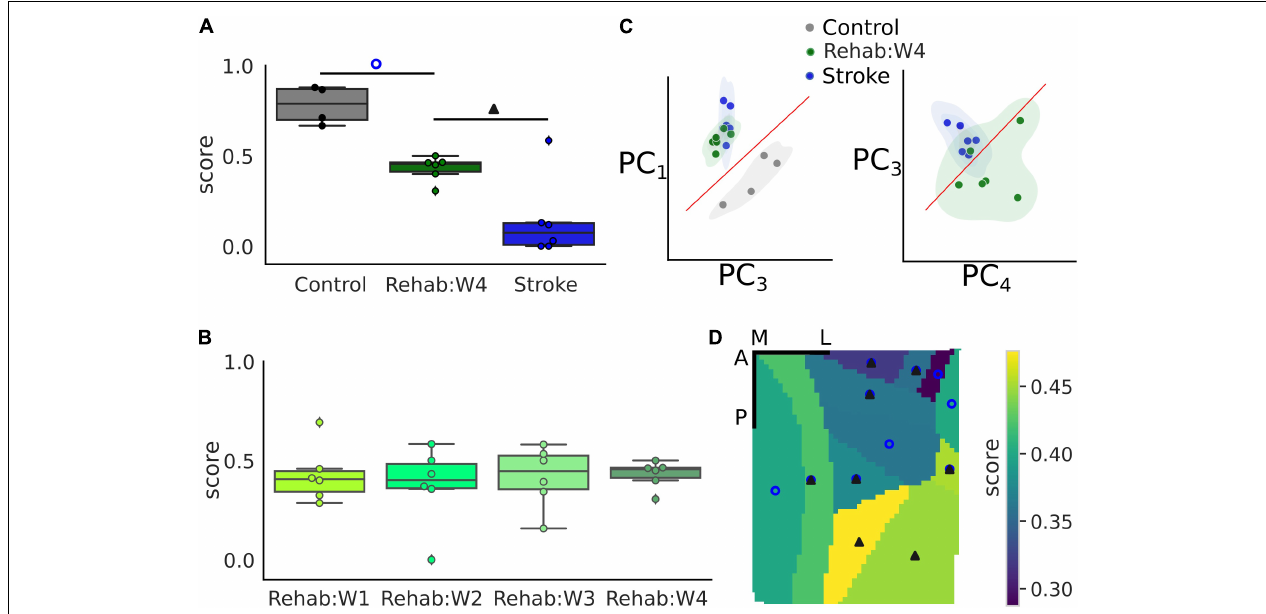
FIGURE 5 | Single-trial classification can discriminate between treatment groups. (A) Boxplot of the recovery score for the different experimental groups. Refer to Figure 2 for a detailed description of the boxplot. The empty blue circle denotes statistically significant differences between the control and the Rehab:W4 group while the solid triangle denotes statistically significant differences between the Rehab:W4 and the Stroke group. Single dots represent the score for the single subject. (B) Boxplot of the recovery score across weeks for the rehabilitation group. Single dots represent the score for the single subject. (C) Representation of the trials in the principal component space. Each dot represents the centroid of all trials for a single subject. (D) Map of the average score of the rehabilitation group for the 12 different parcels. Empty circles and filled triangles denote statistically significant differences as indicated in A. Scale bars in the top right corner are 1 mm in length. For both (A,D) the control group is always statistically significantly different from the stroke group (see Supplementary Table 2 for a list of the areas and the corresponding p